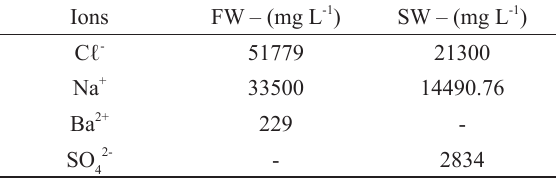
Composition of FW and SW waters used in dynamic